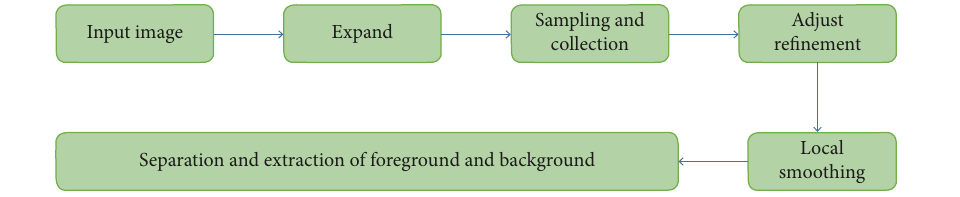
Figure 4: Cutout algorithm based on real-time shared sampling.